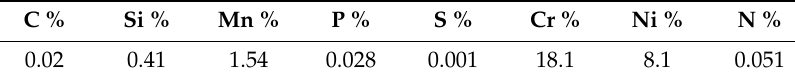
Table 2. Chemical composition of 1.4301 steel [19].